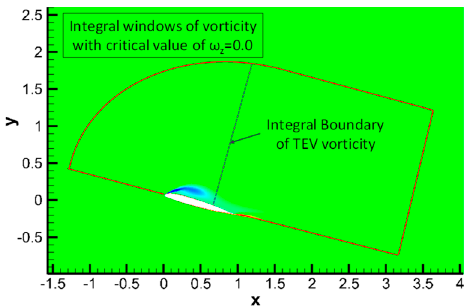
Figure 15. Integral windows of vortex circulation.